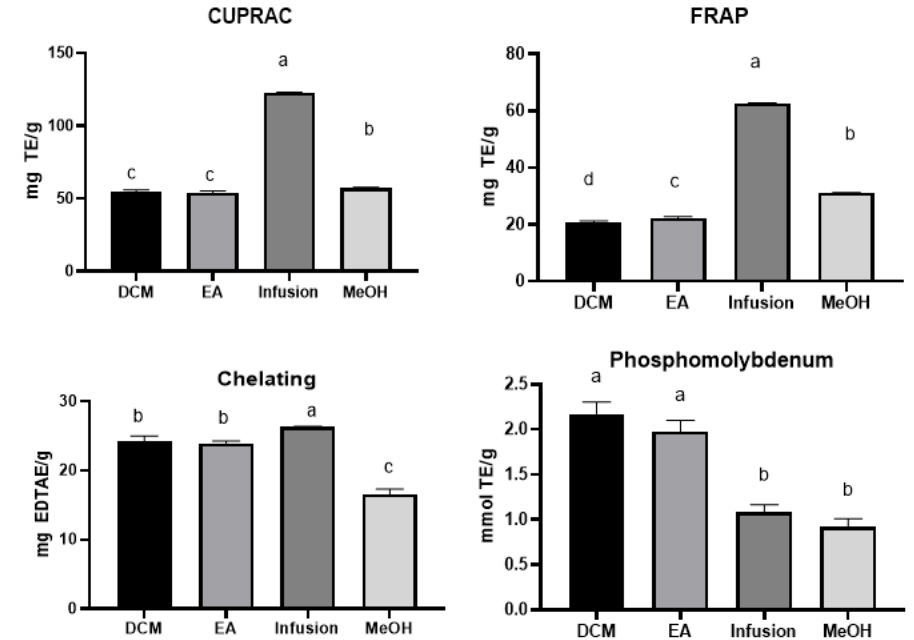
Figure 2. Reducing power (CUPRAC and FRAP), metal-chelating and phosphomolybdenum activities of the tested extracts. Values expressed are means ± S.D. of three parallel measurements. TE: Trolox equivalent; EDTAE: EDTA equivalent. Based on Tukey’s assay at p < 0.05, different letters (a, b, c and d) with in each bar indicated significant differences among the tested extracts (a: the highest